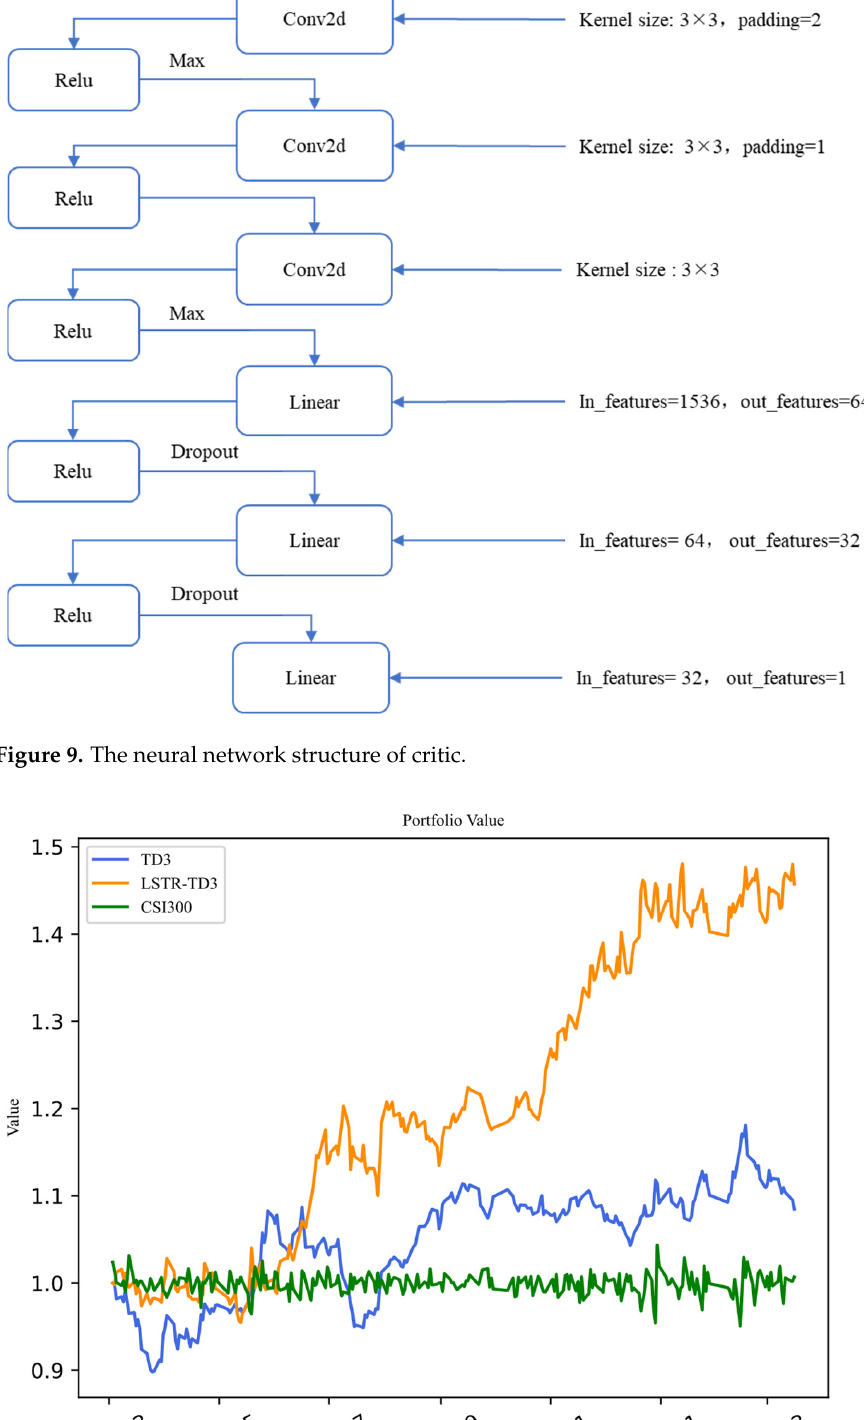
Figure 10. Portfolio value of Portfolio 1.